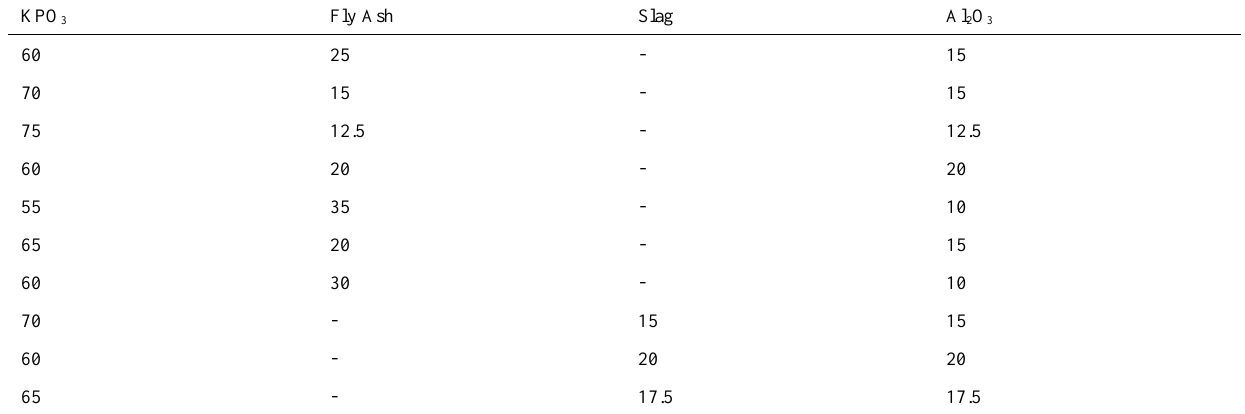
Table 3: Compositions in weight of Series 2 samples that remained under demineralized water for 30 days with no mass loss. KPO